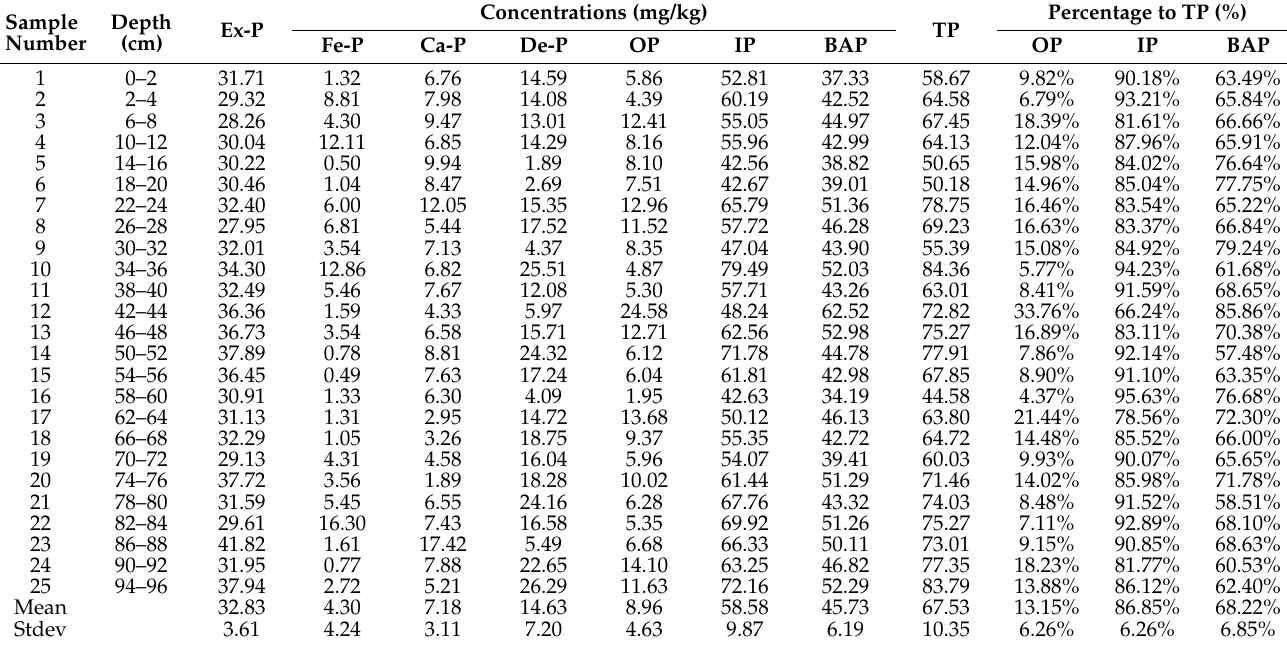
Table A4. Sampling site